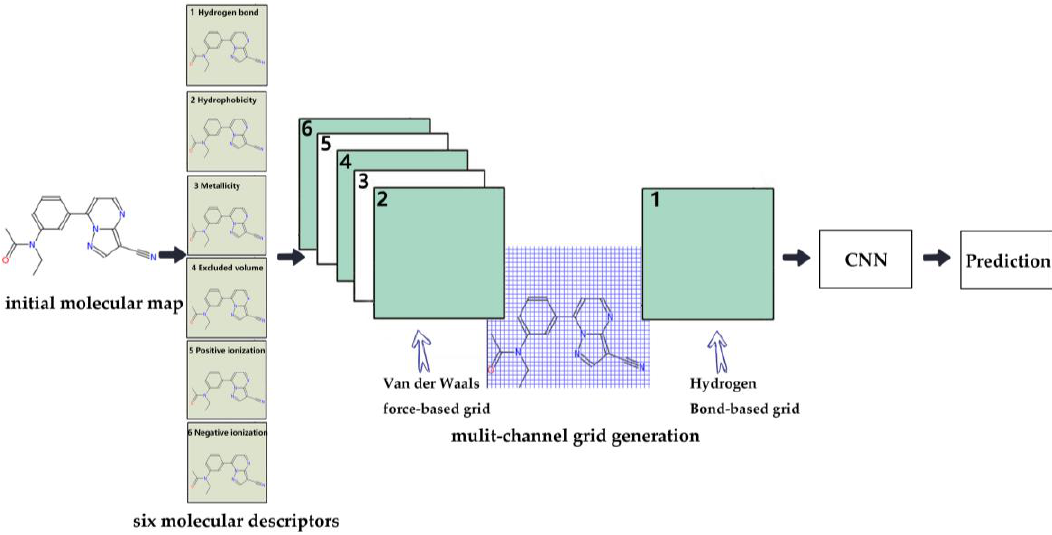
Figure 1. The work flow of the proposed method.